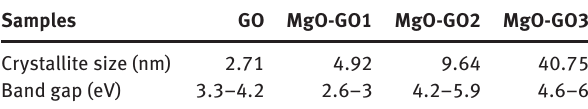
Table 1: Grain size and band-gap values of GO and MgO-GO samples synthesized at different growth temperatures.